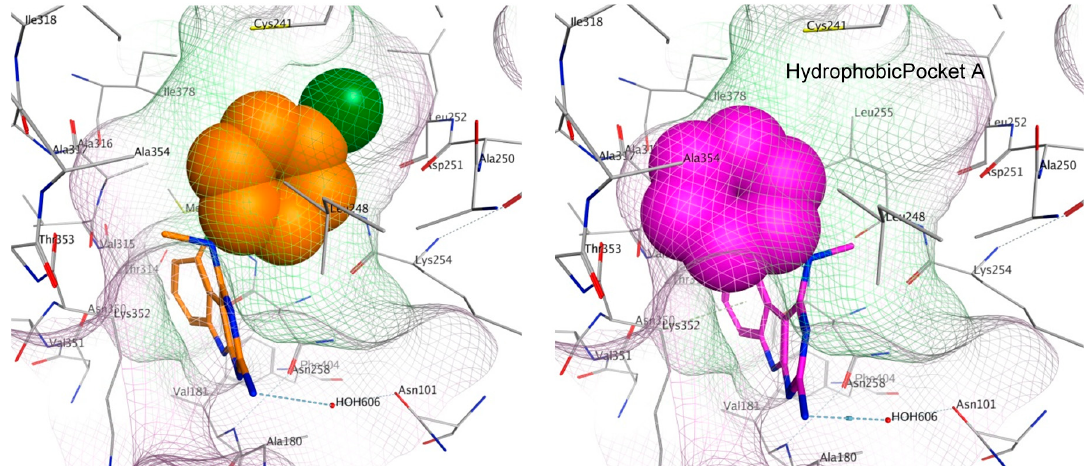
Figure 9. Space fill view of the docked poses of 4 (orange) and 3 (magenta) in the colchicine binding site on tubulin. Hydrophobic surface is in green and hydrophilic surface is in pink.